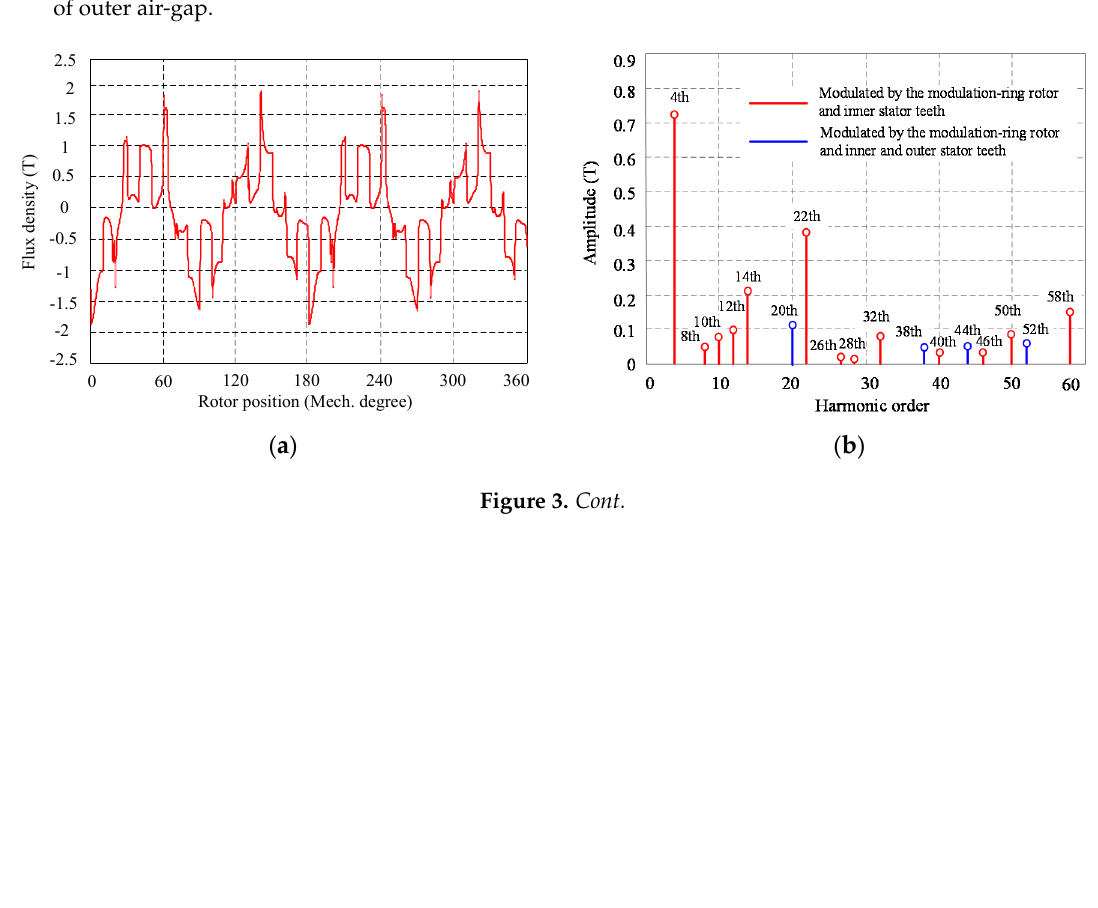
Figure 2. Magnetic flux density with no load: ( a ) Flux density of inner air-gap; ( b ) Harmonic order of flux density of inner air-gap; ( c ) Flux density of outer air-gap; and ( d ) Harmonic order of flux density of outer air-gap.